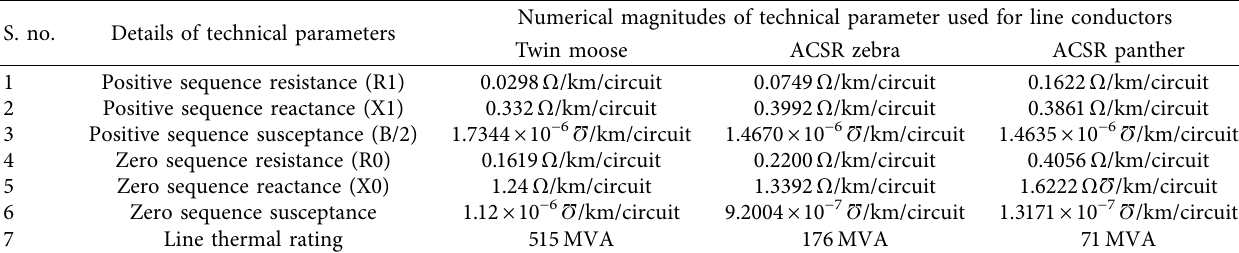
Table 6: Description of conductors of transmission lines.